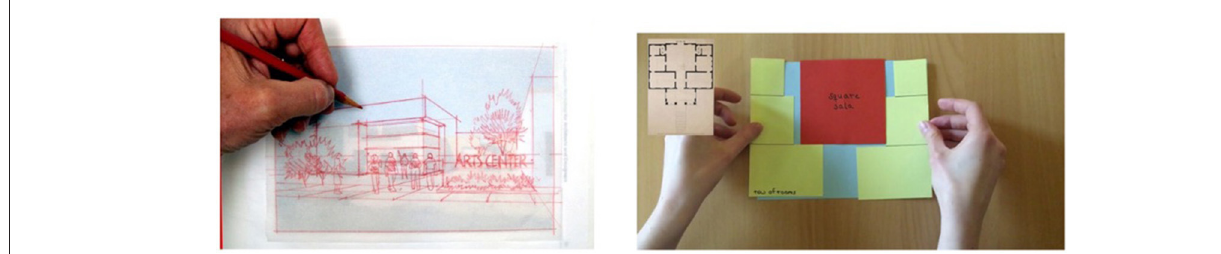
FIGURE 7 | Tracing paper modeling (left) compared with one of Student O’s ‘flat’ models (right).